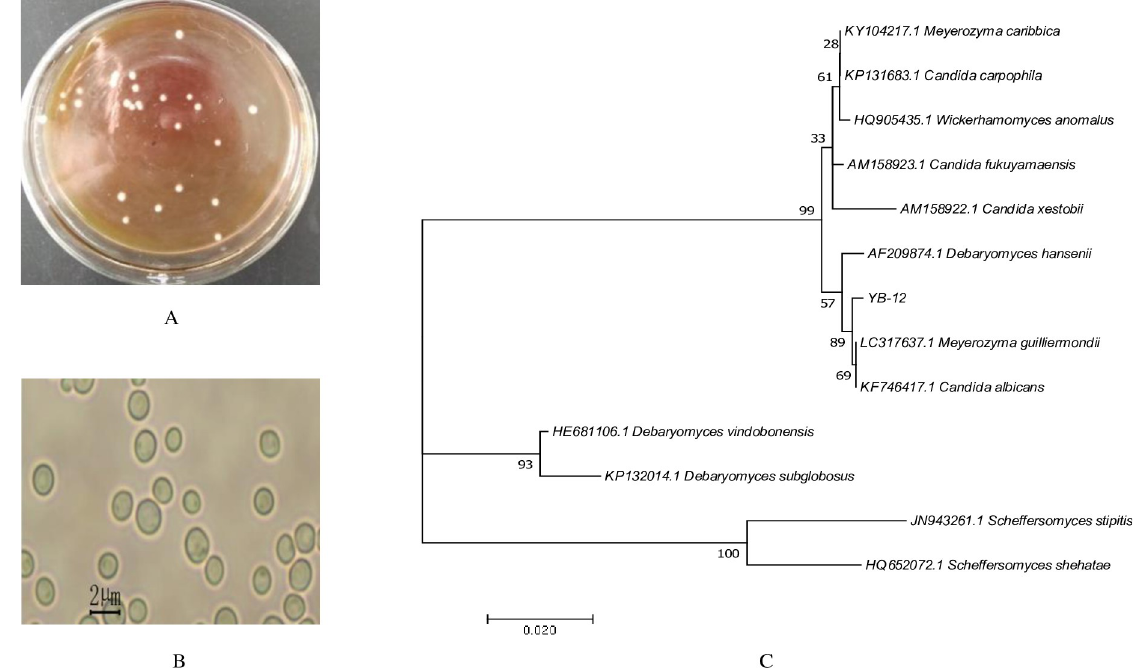
Fig 2. Morphological and molecular characterization of YB-12. A: Colony morphology. B: Cellular morphology. C: Phylogenetic trees of partial 26S rRNA gene sequences showing the relationships between YB-12 and its relatives. The tree was constructed via the NJ method. The scale bar represents 2% nucleotide substitutions. Bootstrap values are indicated at each